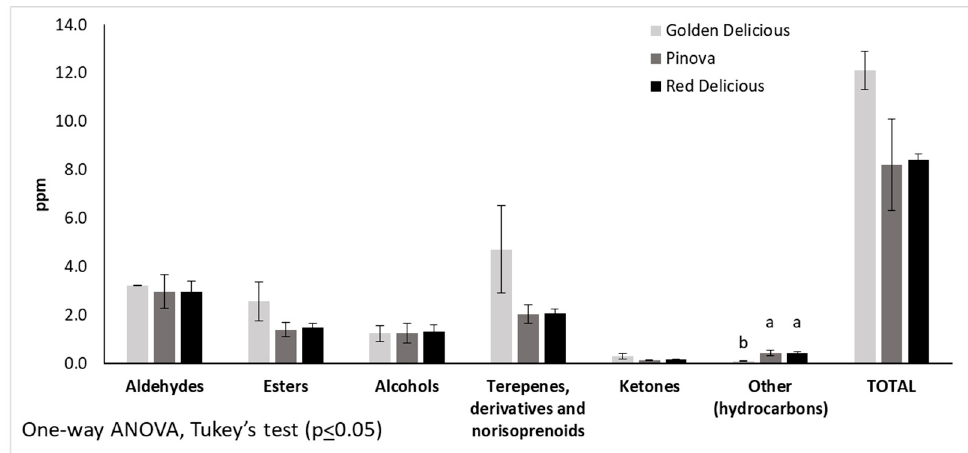
Figure 2. Volatile composition and amount of fruits pertaining to three apple cultivars. The means with different letters are significantly different ( p < Table 3. Presence/absence of the different aromatic compounds in the apple cultivars’ samples (fruits and juices). Golden Delcious Pinova Red Delicious. Compounds